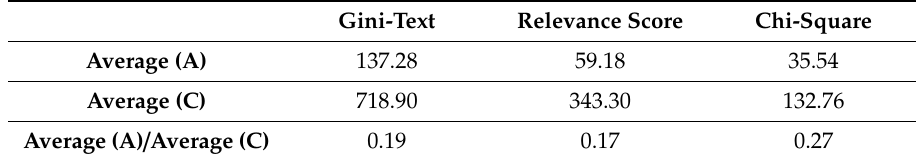
Table 4. Average (A), average (C), and average (A)/average (C) in the anger category using the topmost 50 terms.